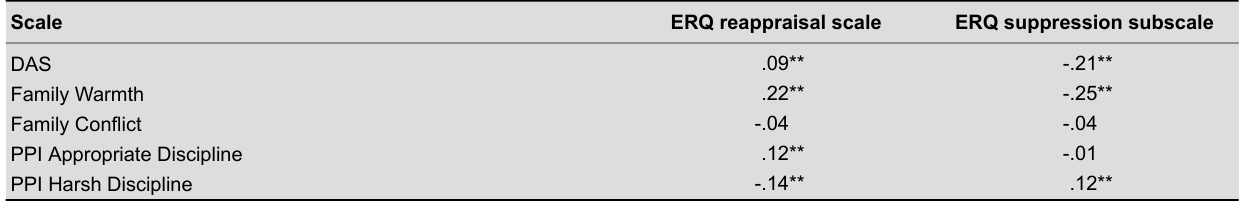
Correlations Between the ERQ Subscales and Couple Adjustment, Family Warmth and Conflict, as Well as Appropriate and Harsh Parenting.